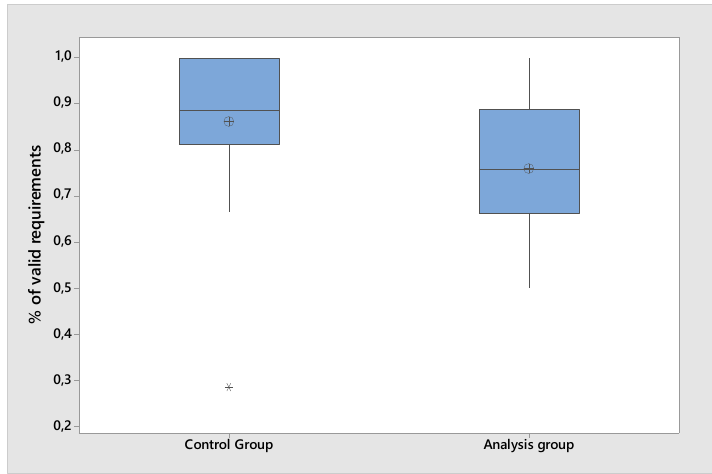
Figure 4. Boxplot of the fraction of valid requirements produced by each subject.